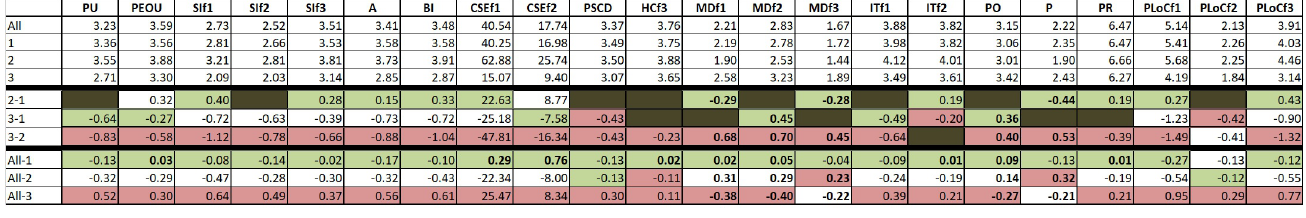
Figure 4. The table describes the differences in the average values of all the variables. For a given variable (a column), green values indicate the highest difference in absolute value, and red values indicate the smallest. Dark brown cells indicate non-meaningful differences for a variable in a pair of clusters.